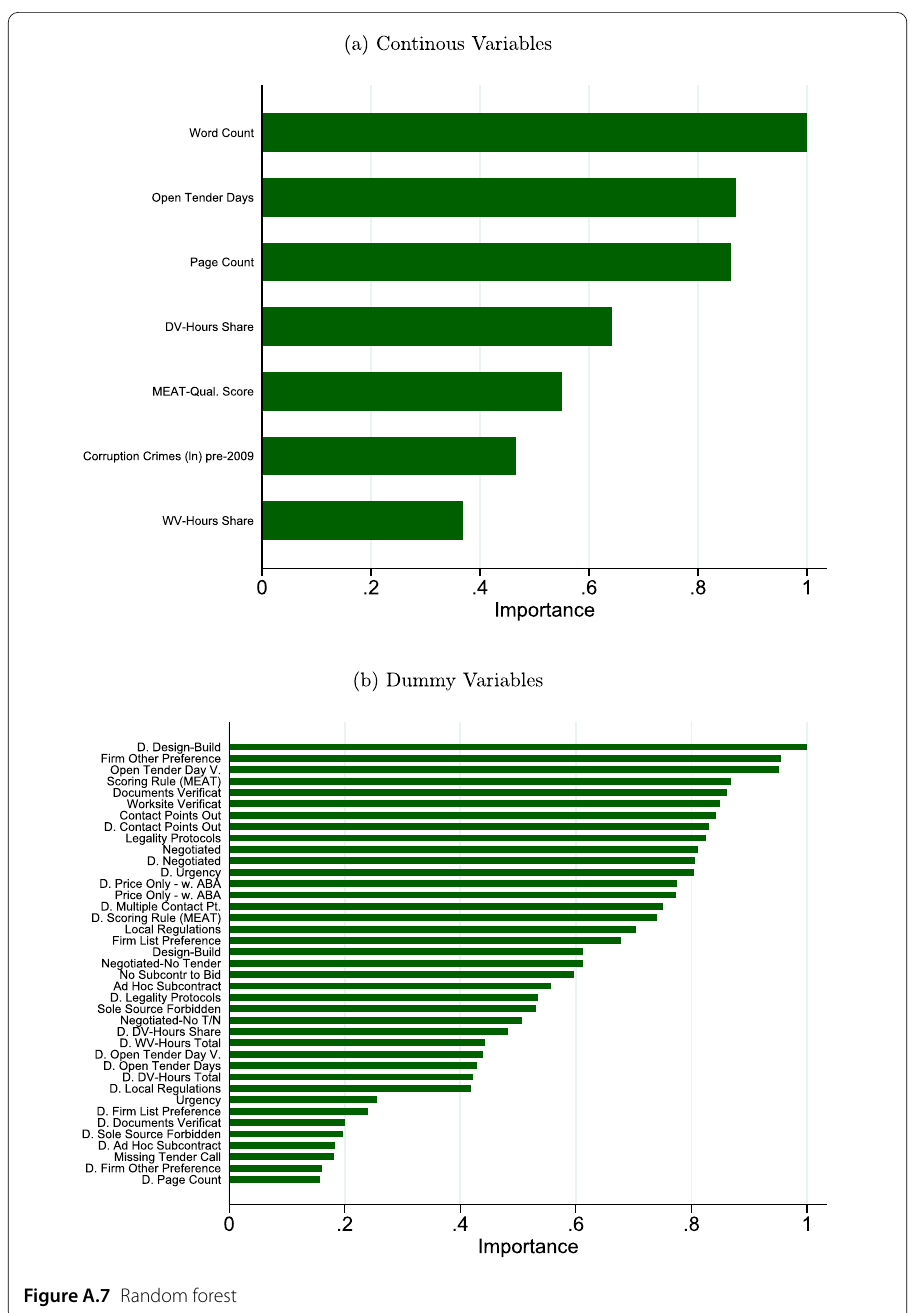
Figure A.7 Random